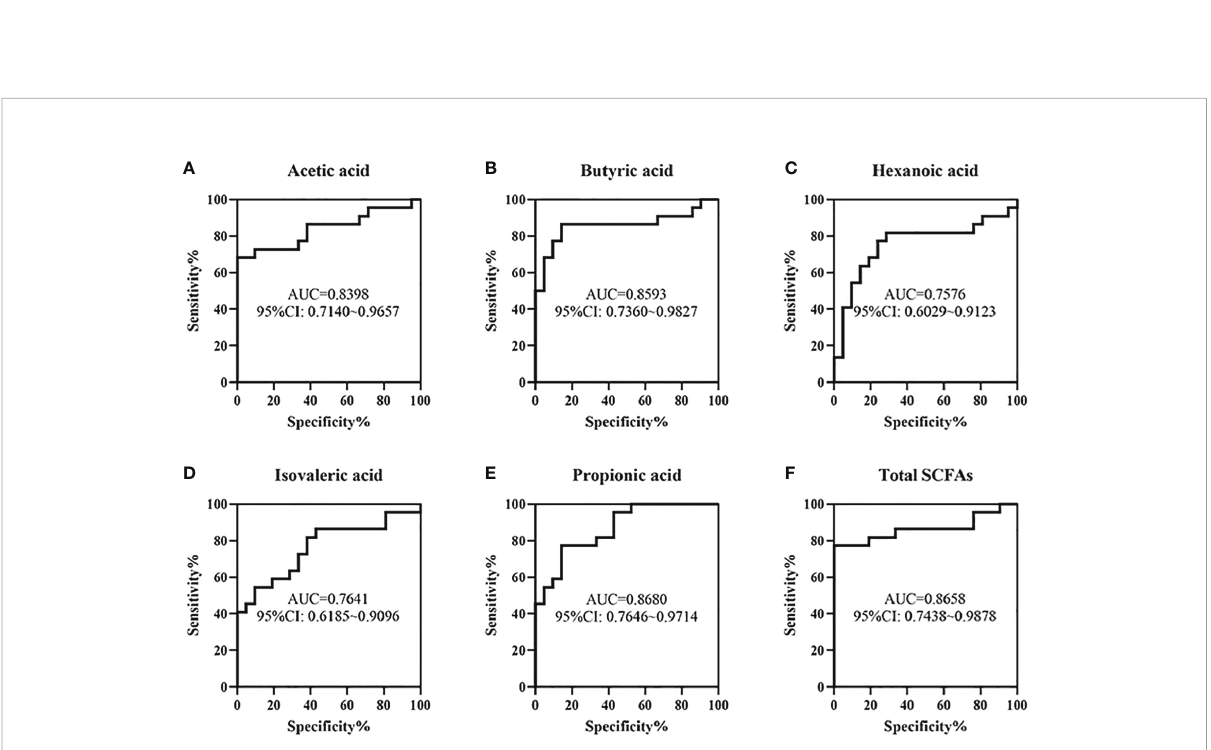
FIGURE 8 The value of some short chain fatty acids (SCFAs) in the early identi fi cation of necrotizing enterocolitis (NEC) and food protein-induced allergic protocolitis (FPIAP) by receiver operating characteristic (ROC) analysis. The area under curves ( AUCs) of acetic acid (A) , butyric acid (B) , hexanoic acid (C) , isovaleric acid (D) , propionic acid (E) , and Total SCFAs (F) were 0.8398, 0.8593, 0.7576, 0.7641, 0.8680, and 0.8658, respectively. N =22 for NEC and N =21 for